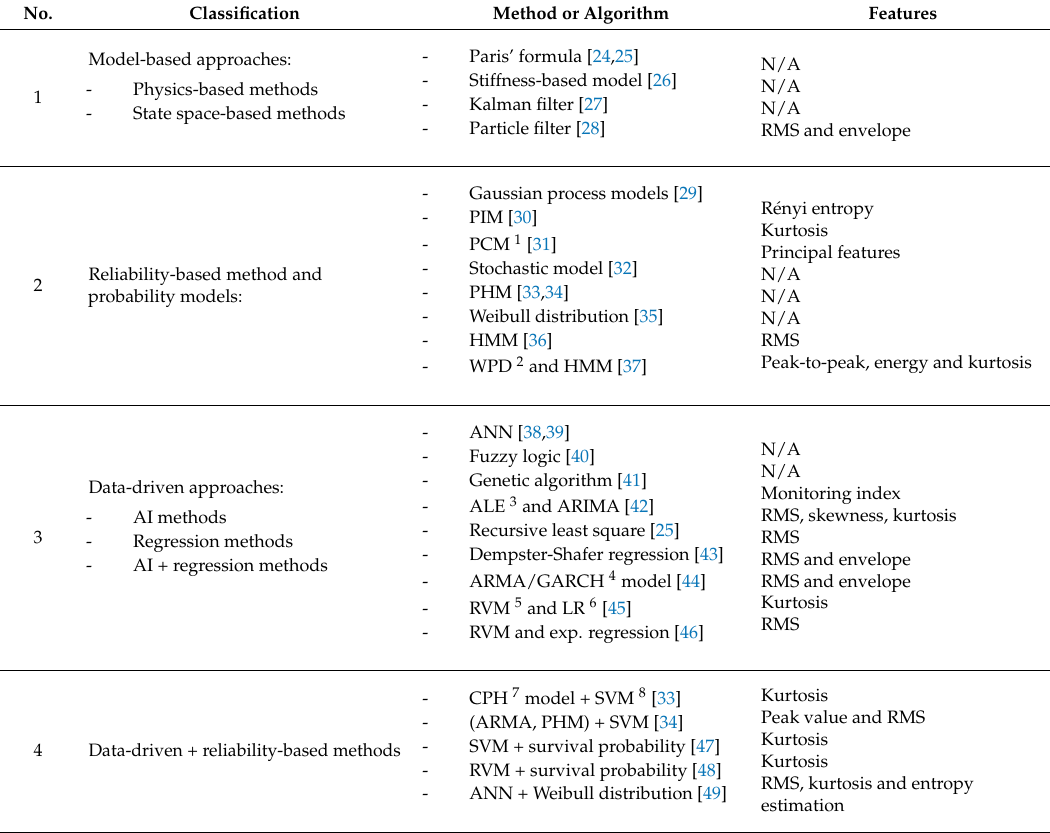
Table 1. Prognosis methods for rolling element